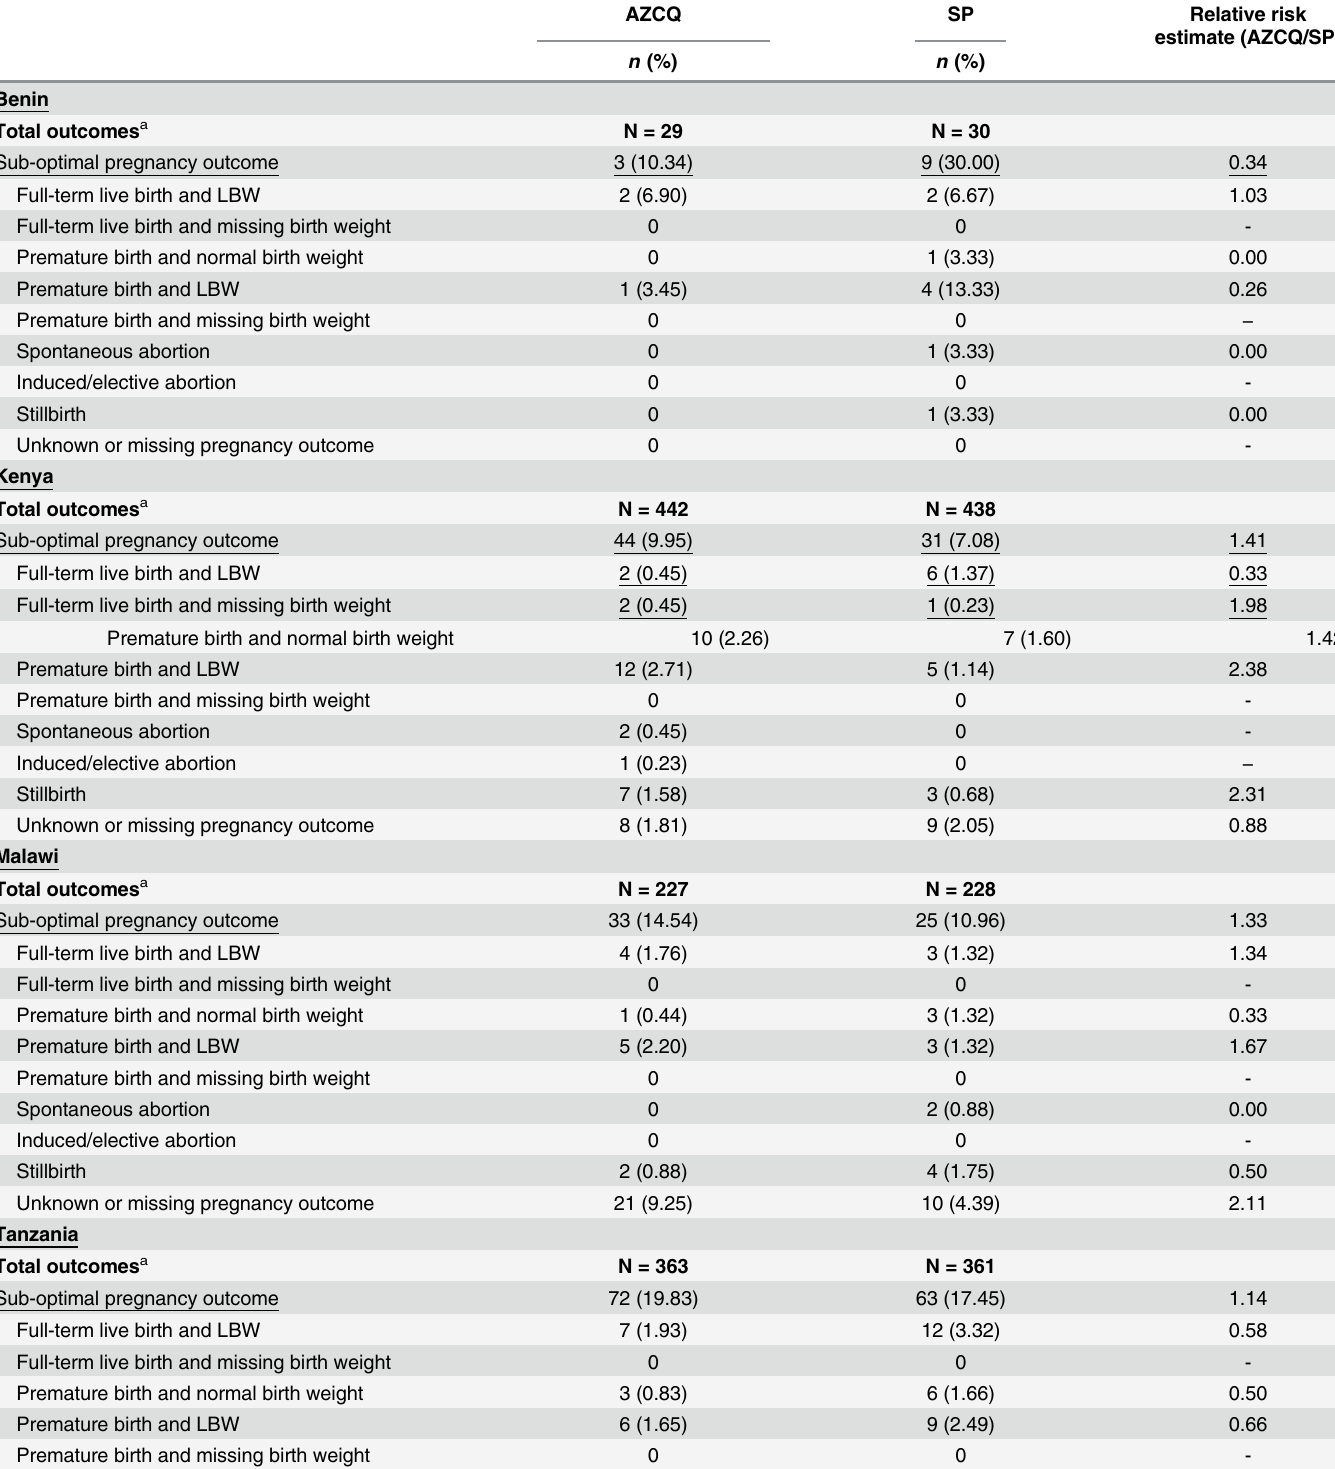
Table 3. Incidence of sub-optimal pregnancy outcome (primary endpoint) in ITT (efficacy analyzable) population, by country.